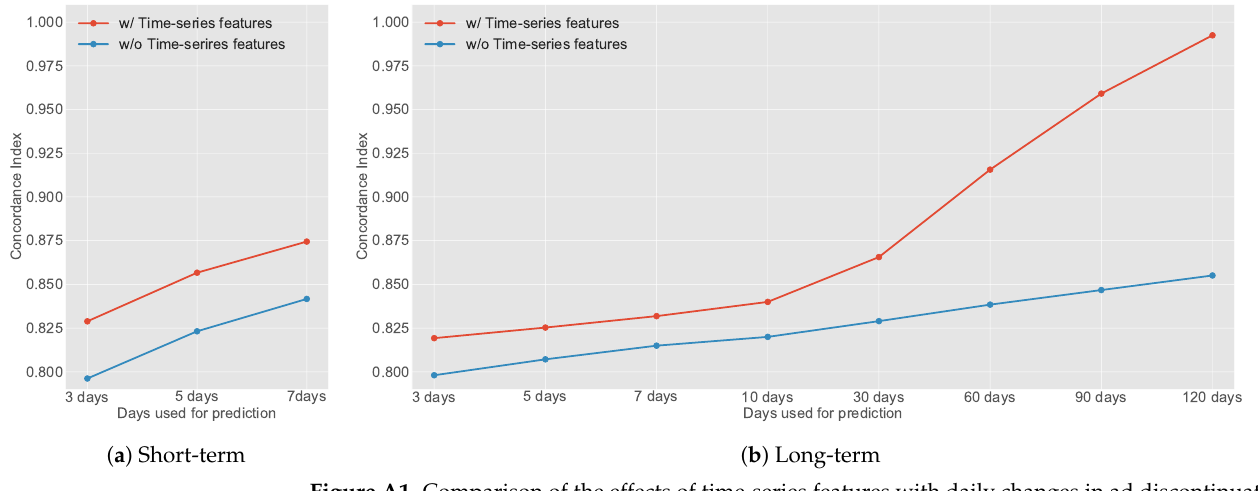
Figure A1. Comparison of the effects of time-series features with daily changes in ad discontinuation prediction task. For the short- and the long-term models, the more days that can be used for prediction, the higher the performance. In the long-term model, when used for prediction for 30 days or more, the concordance index is dramatically improved compared with the case where the time-series feature is not